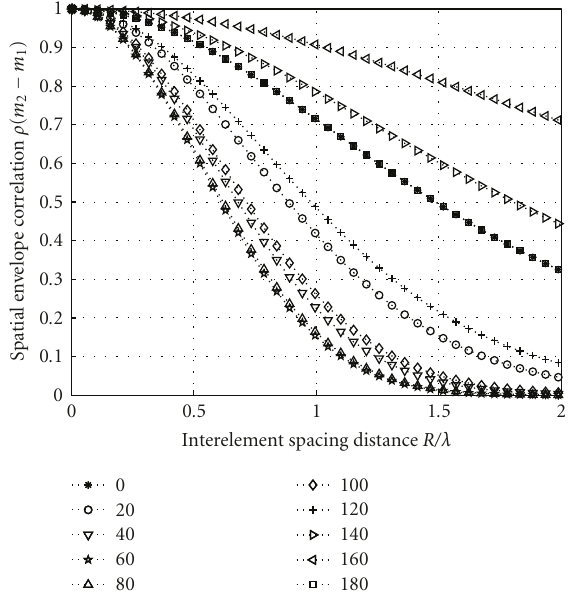
Figure 2: Spatial correlation between 2 elements located at 45 ◦ and 90 ◦ , respectively. Azimuth is varied from ϕ o = 0 ◦ to 180 ◦ for a constant mean elevation ϑ o = 90 ◦ and κ = 20. Figure 3: This figure illustrates the e